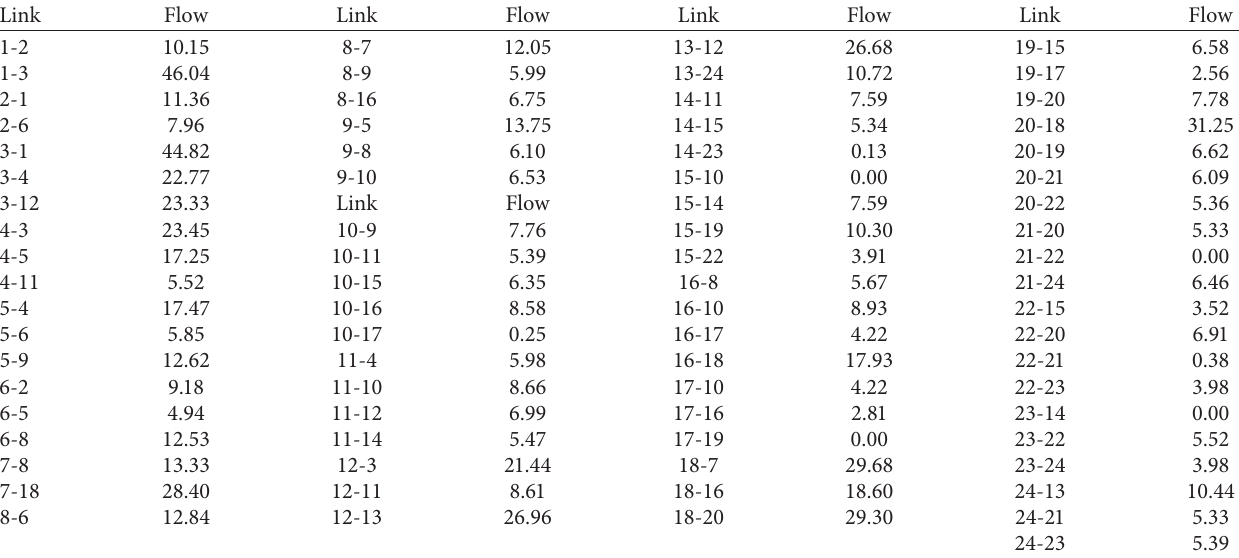
Figure 2: Base case result in the Sioux Falls network. (a) Location design of the ER. (b) Performance of the SP algorithm. Table 3: Equilibrium link flow (10 3